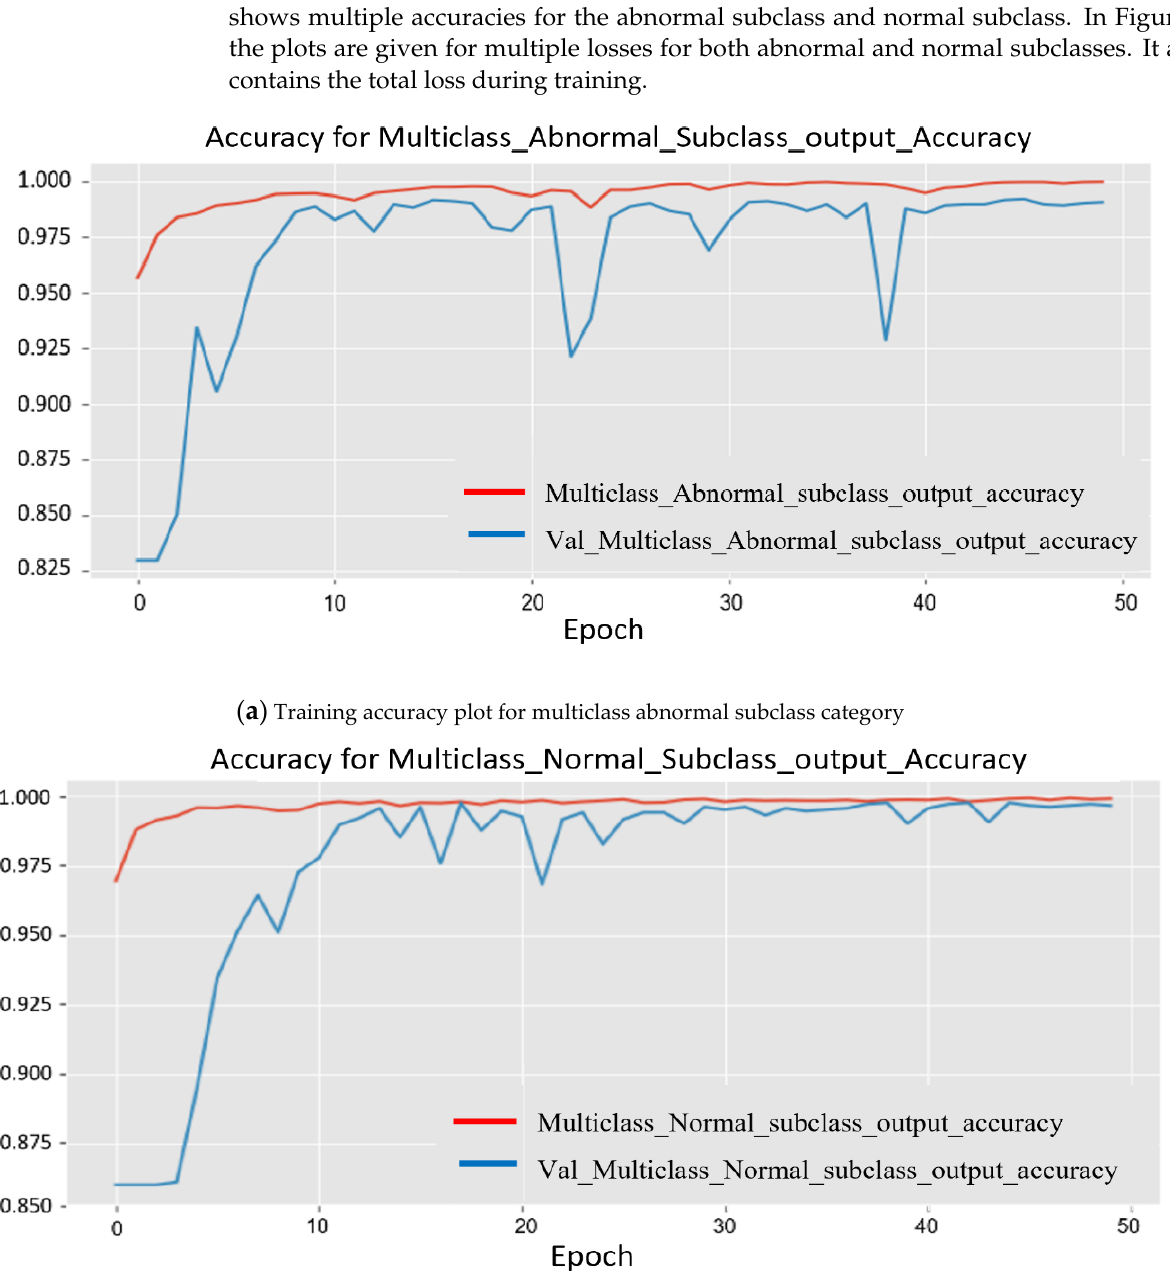
Table 4. Results obtained by classification model on Olmos test set.